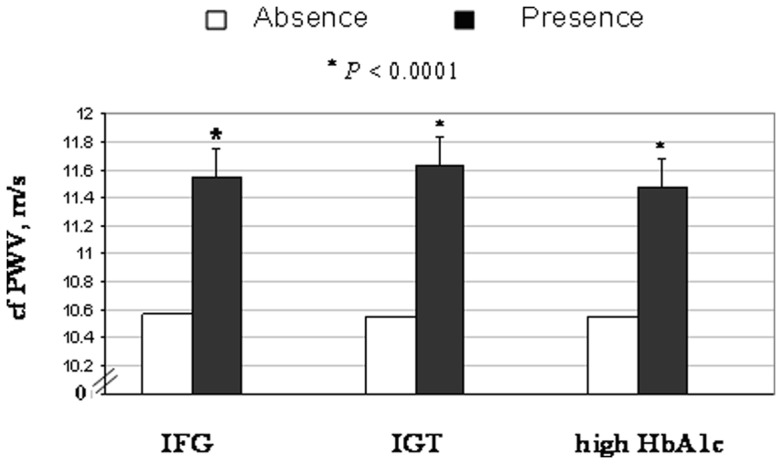
Geometric means of carotid-to-femoral pulse wave velocity (cfPWV, in m/s) by the presence of prediabetes status defined by IFG, IGT, and high HbA1c (5.7–6.4%).The analyses were adjusted for age, sex, BMI, MAP, heart rate and lipids (total cholesterol, triglyceride, HDL-C and LDL-C). Symbol ‘*’ represents significant difference (p<0.05) between the ‘absence’ and ‘presence’ groups of each marker.